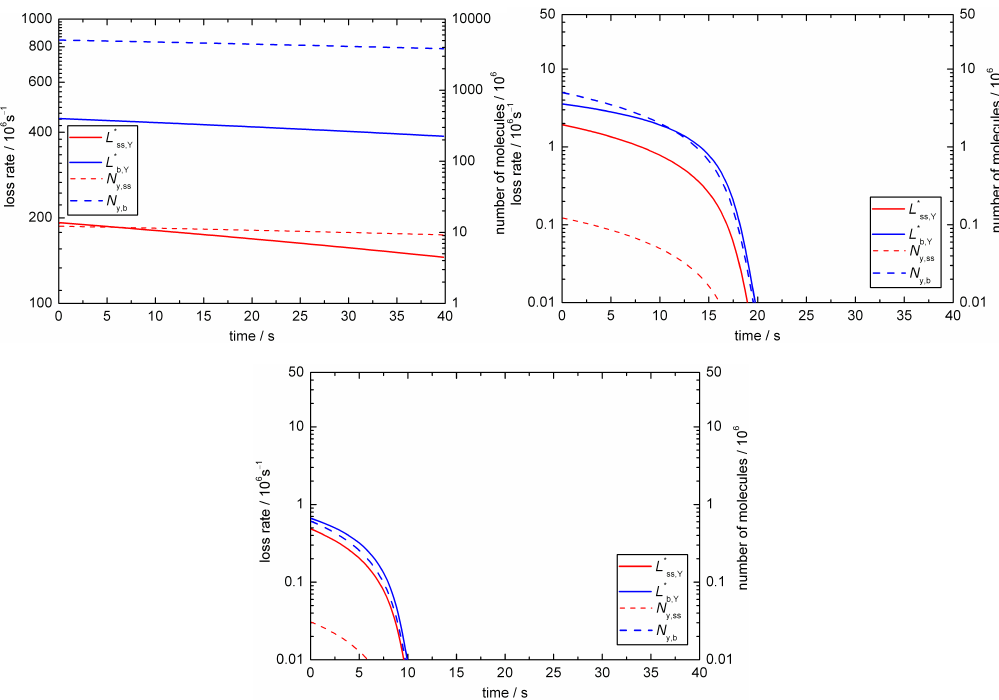
Fig. 5. Temporal evolution of aerosol particle composition and kinetic parameters in sensitivity studies for BC1 with a range of droplet radii: (a) 1000nm, (b) 100nm and (c) 50nm. Plots are analogous to Fig.